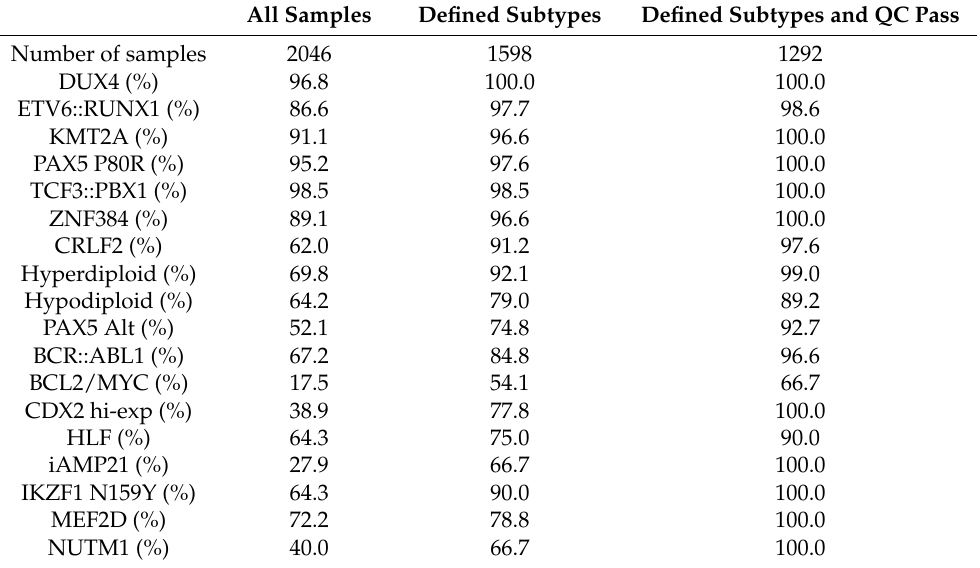
Table 2. Positive predictive values for correct classification into genetically defined B-cell ALL subtypes. The values are presented as the percentages of samples for which the best matching RNA centroid was the same as the genetic subtype if defined. Quality control was set at ≥ 50% proximity and ≥ 50% exclusivity (details in